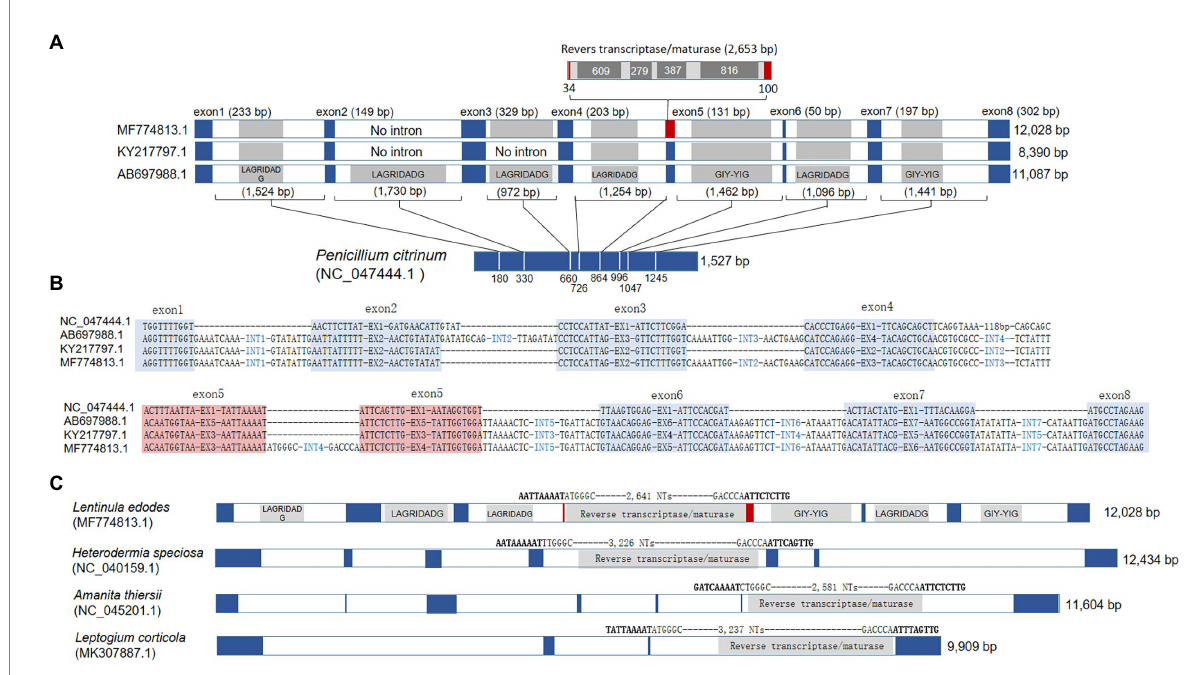
FIGURE 3 Gene structure variations of cox1 . (A) Comparison of Lentinula edodes cox1 ( Le _ cox1 ) with archetypal cox1 in the mtDNA of Penicillium citrinum (Pc_cox1) . Intronic homing nuclease genes are shaded inside introns. Intron insertion sites at Pc_cox1 are depicted by white lines with their positions from the 5 ′ -end. The split exon by a group II intron in MF774813.1 is red-boxed. (B) Intron insertion sequences in cox1 . Exonic regions are blue-shaded. The spilt exon in MF774813.1 are red-shaded. (C) The presence of homologous group II intron in different cox1 of fungal mtDNAs. Exons are colored in blue. The intron insertion sequence and the length of the group II inton are provided at the top of the